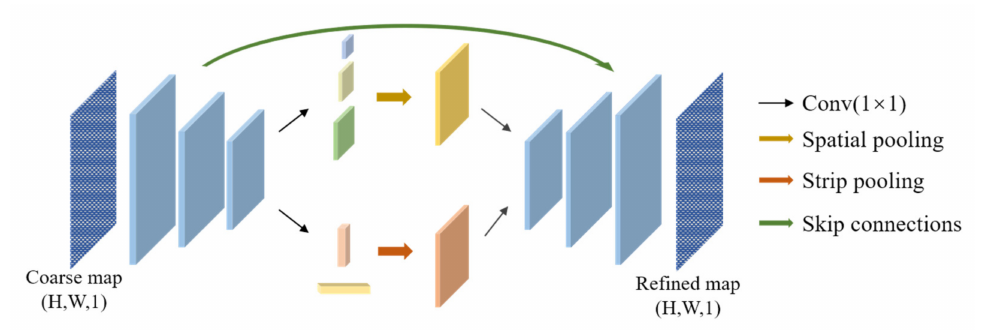
Figure 3. Designed refined network